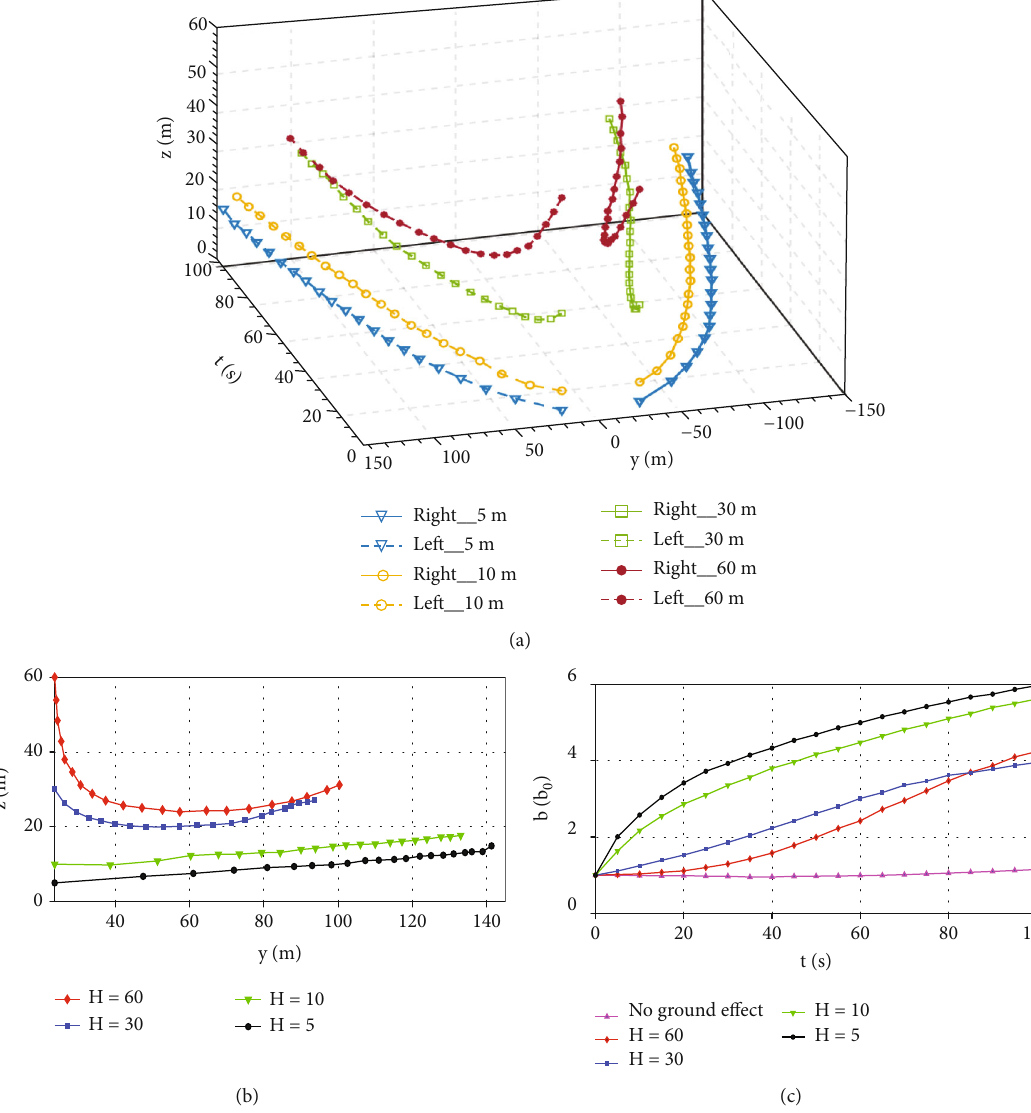
Figure 9: Changes in the wake vortex position at di ff erent heights from the ground. (a) The position of the vortex center varies with time; (b) the movement trajectory of the wake vortex center; and (c) the variation in vortex center